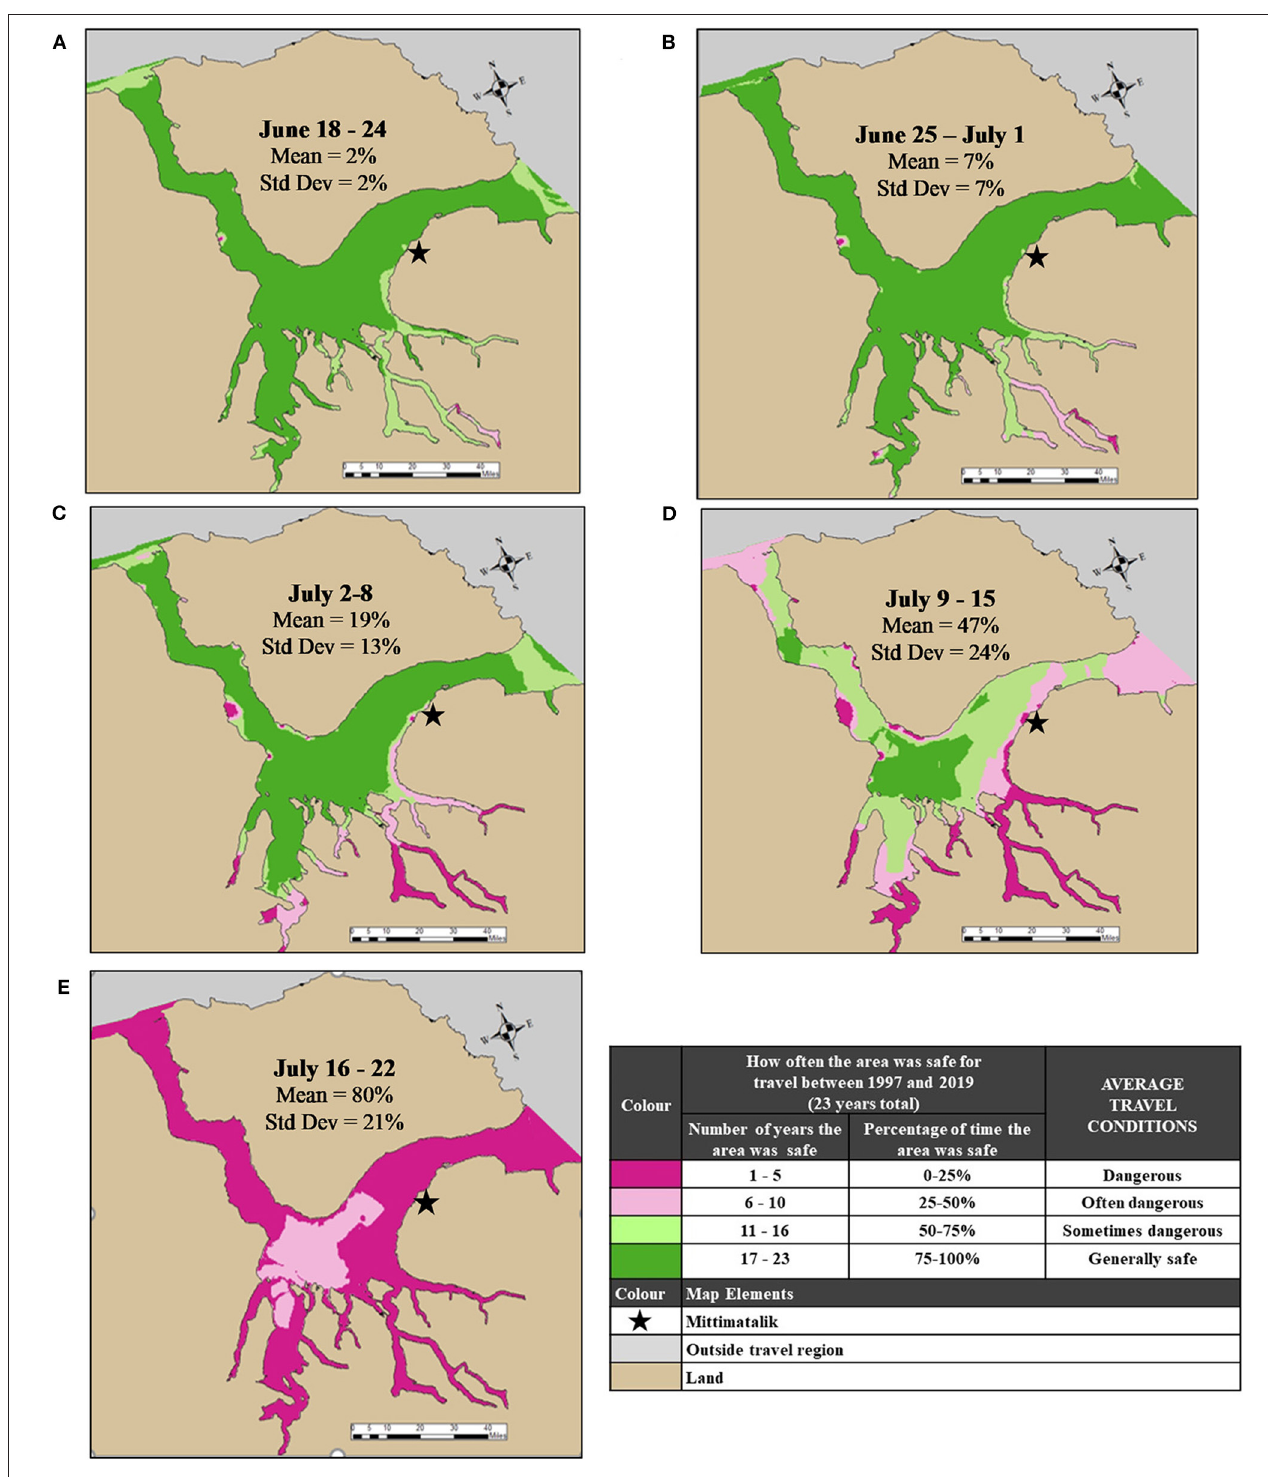
FIGURE 11 | Maps showing weekly average break-up conditions June 18 to July 22, 1997–2019. (A) Average break-up, June 18–24. (B) Average break-up, June 25–July 1. (C) Average break-up, July 2–8. (D) Average break-up, July 9–15. (E) Average break-up, July 16–22.